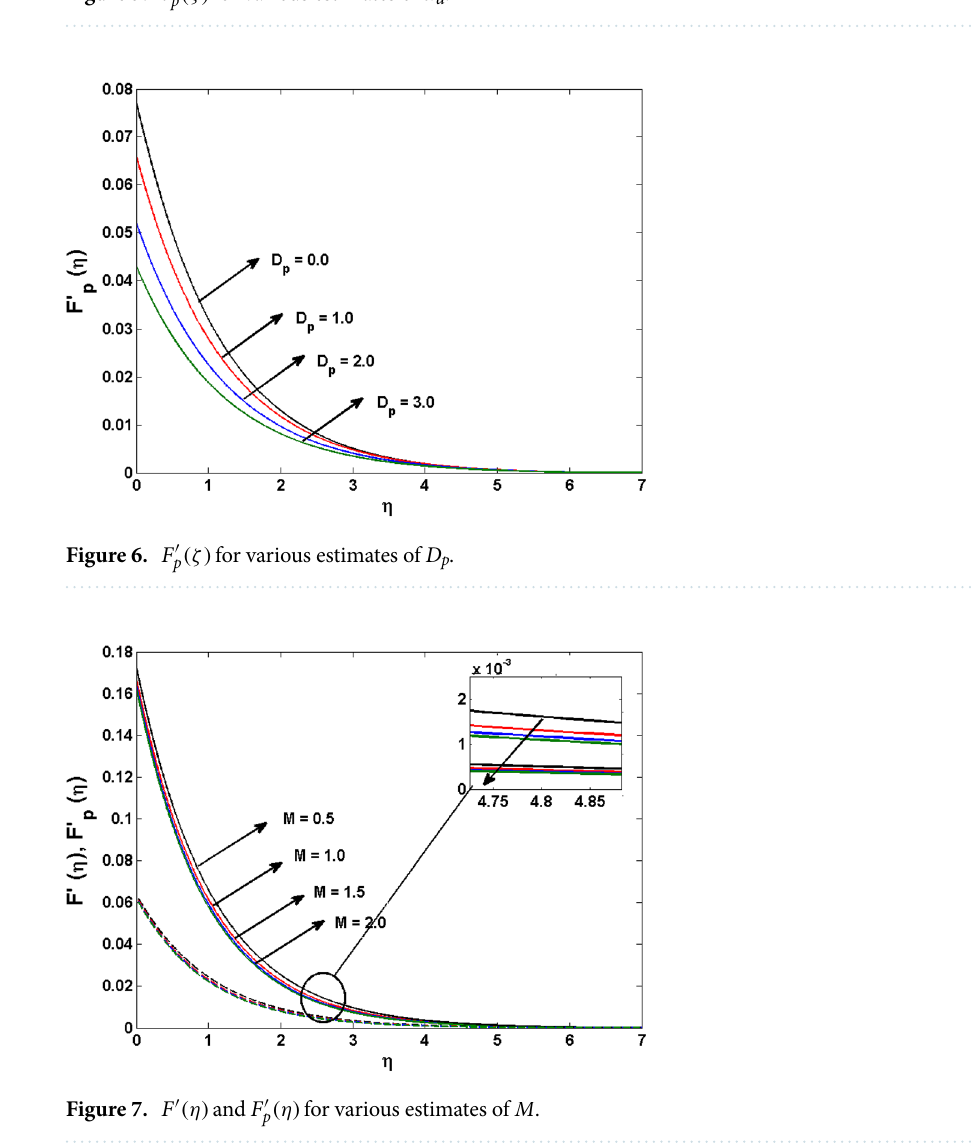
Figure 5. θ ′ p (ζ) for various estimates of α d .